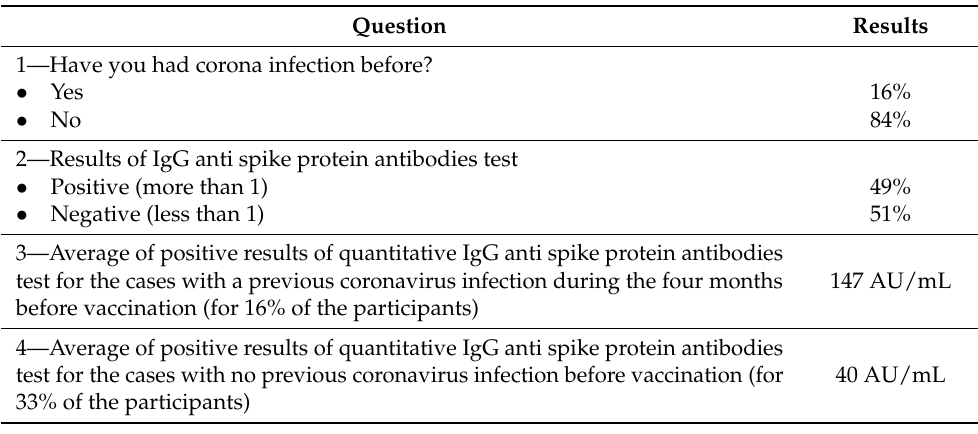
Table 4. The results of IgG anti spike protein antibodies test and laboratory tests at day 18 after vaccination with Sinopharm